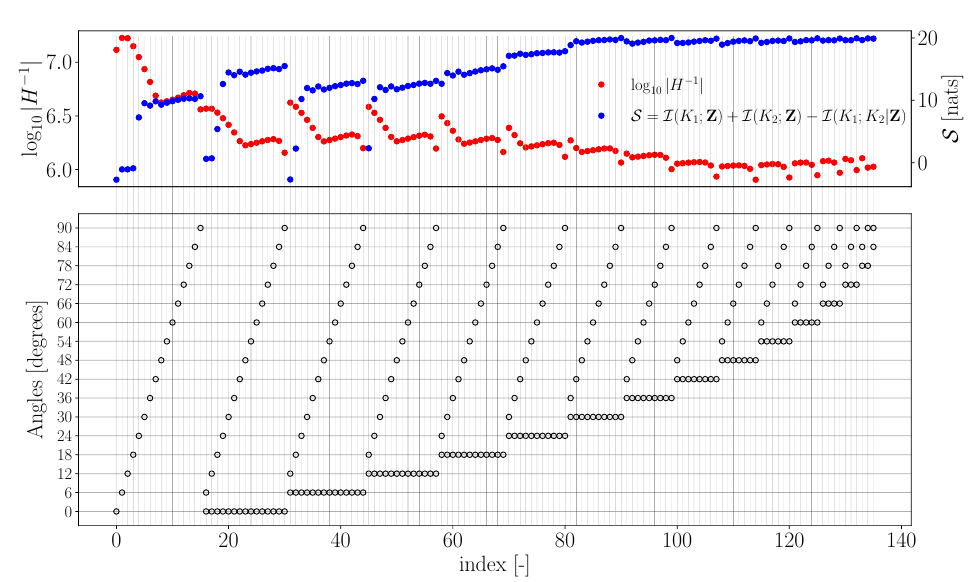
Figure 11. Information criterion Information Matrix log maximum of two angles. The upper panel shows the angles (with circles) in the corresponding